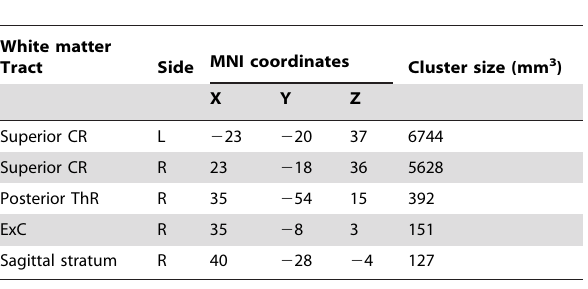
Table 2. White matter clusters where a main effect of diagnosis emerged in fractional anisotropy.